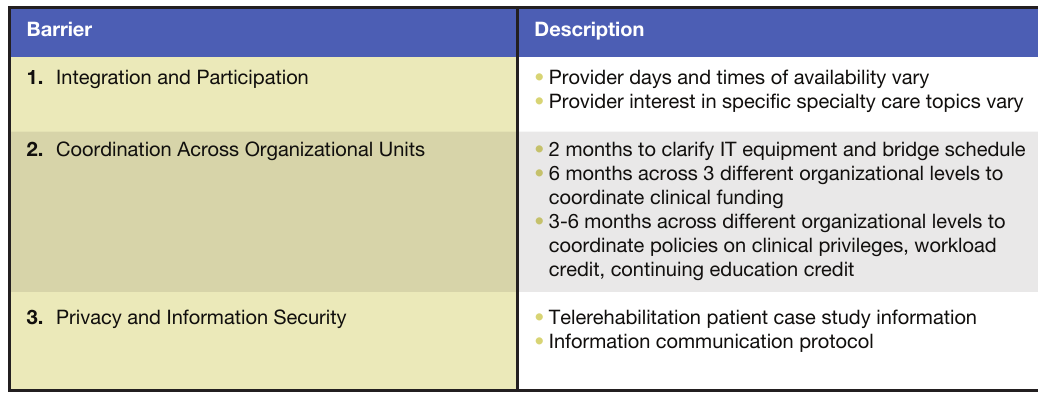
Table 2: Barriers in Implementation of TR Specialty Consultation Pilot